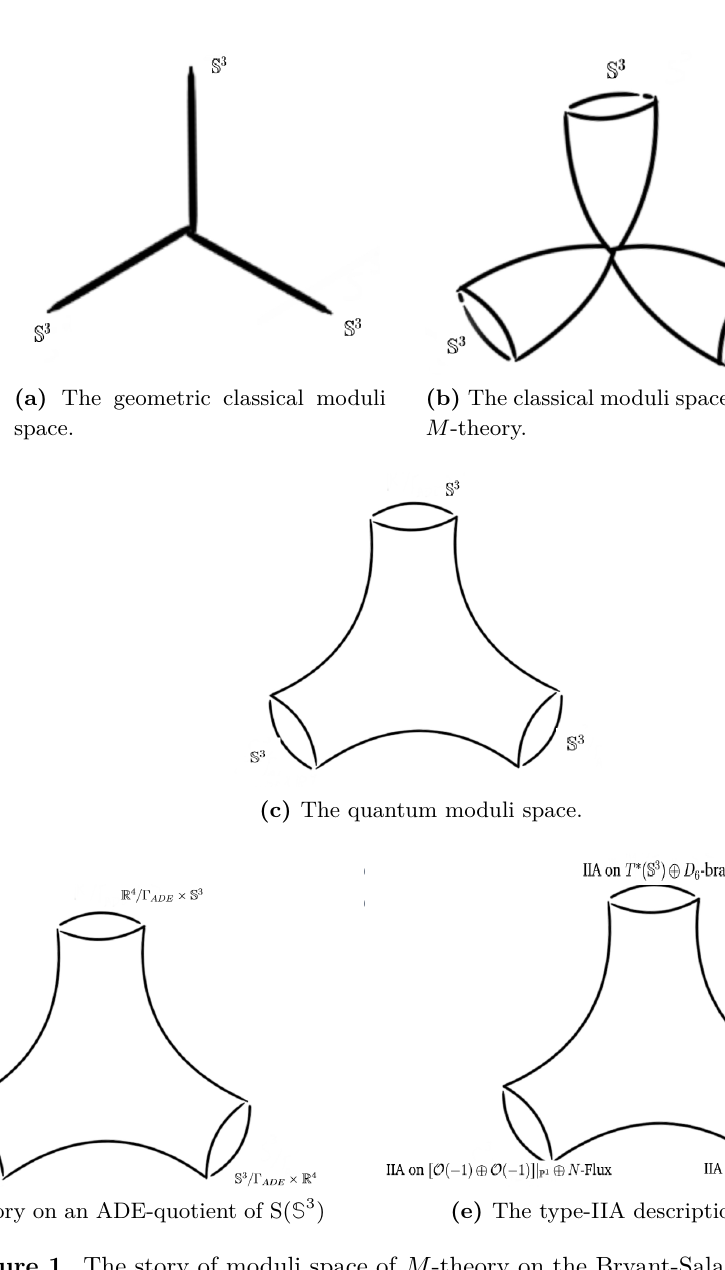
Figure 1. The story of moduli space of M -theory on the Bryant-Salamon G 2